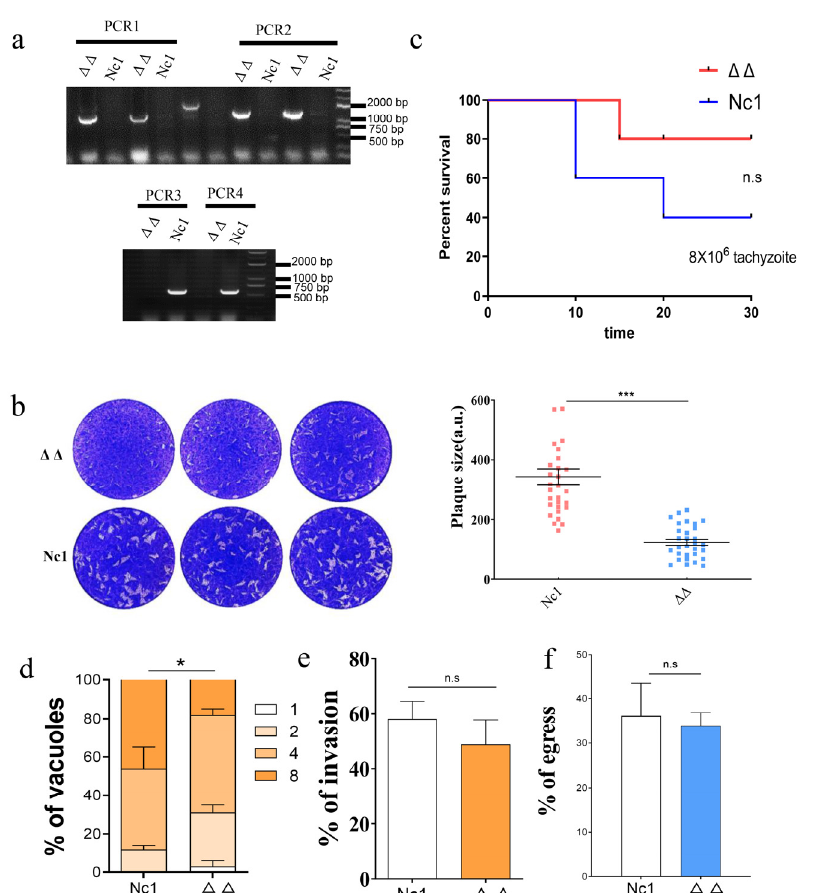
Figure 4. Lack of GRX S14 and GRX C5 together affected the growth of parasites. ( a ) PCR identifi- cation of the Δ grx S14 Δ grx C5 strain. PCR1 and PCR2 suggest successful homologous integration; in PCR3 and PCR4, fragments of grx S14 and grx C5 were amplified. ( b ) Plaque assay comparing the growth of wild-type and knockout parasites. ( c ) Mouse survival after infection with different strains.